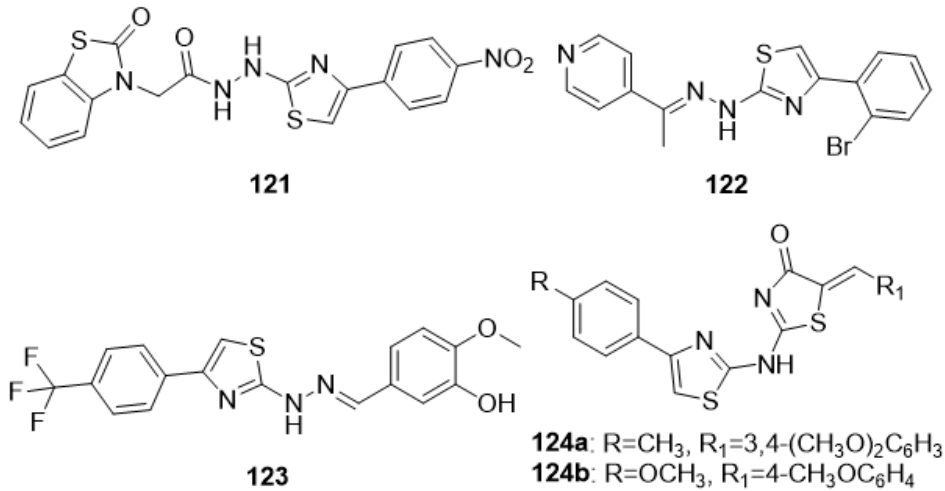
Figure 10. Thiazoles that have recently been planned and synthesized as possible anti-Alzheimer medicines.